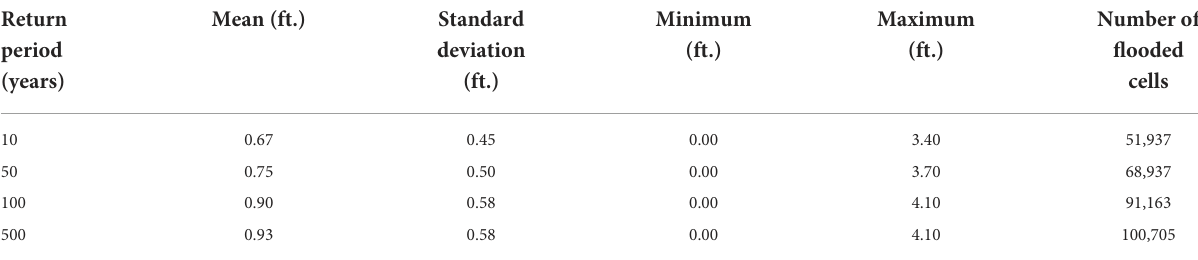
TABLE 1 Descriptive statistics of preliminary (uncleaned) flood depths (feet) by return period for the Metairie, Louisiana, study area.